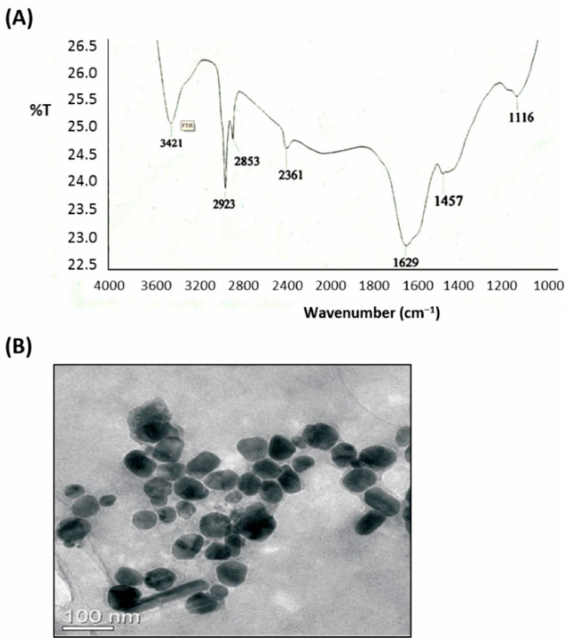
Figure 3. FTIR spectrum and TEM of AgNPs synthesized by C. gigantean . ( A ) The FTIR spectrum of the synthesized AgNPs from C. gigantean leaf showing seven distinct peaks at 1116, 1457, 1629, 2361, 2853, 2923, and 3421 cm − 1 , revealing the existence of amide, amino, and alkane groups. This proved the availability of abundant chemical constituents that had bound onto the synthesized AgNPs. ( B ) A TEM image showing the spherical shape nanoparticles, where the size was in the range of ≈ 10–70 nm. The AgNPs were distributed uniformly without significant